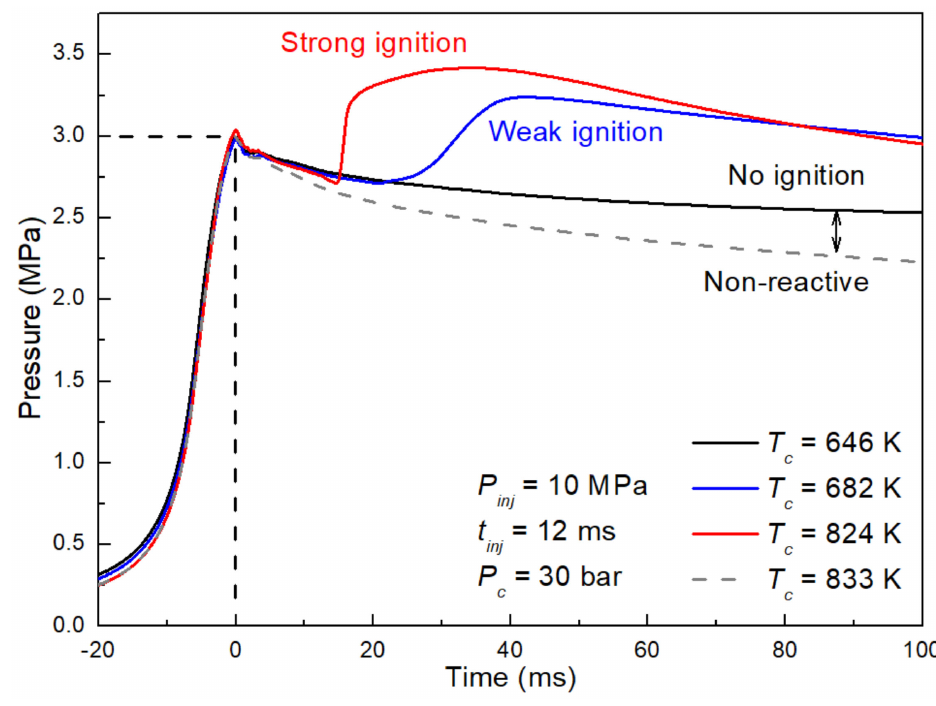
Figure 6. Effect of EOC temperature on spray